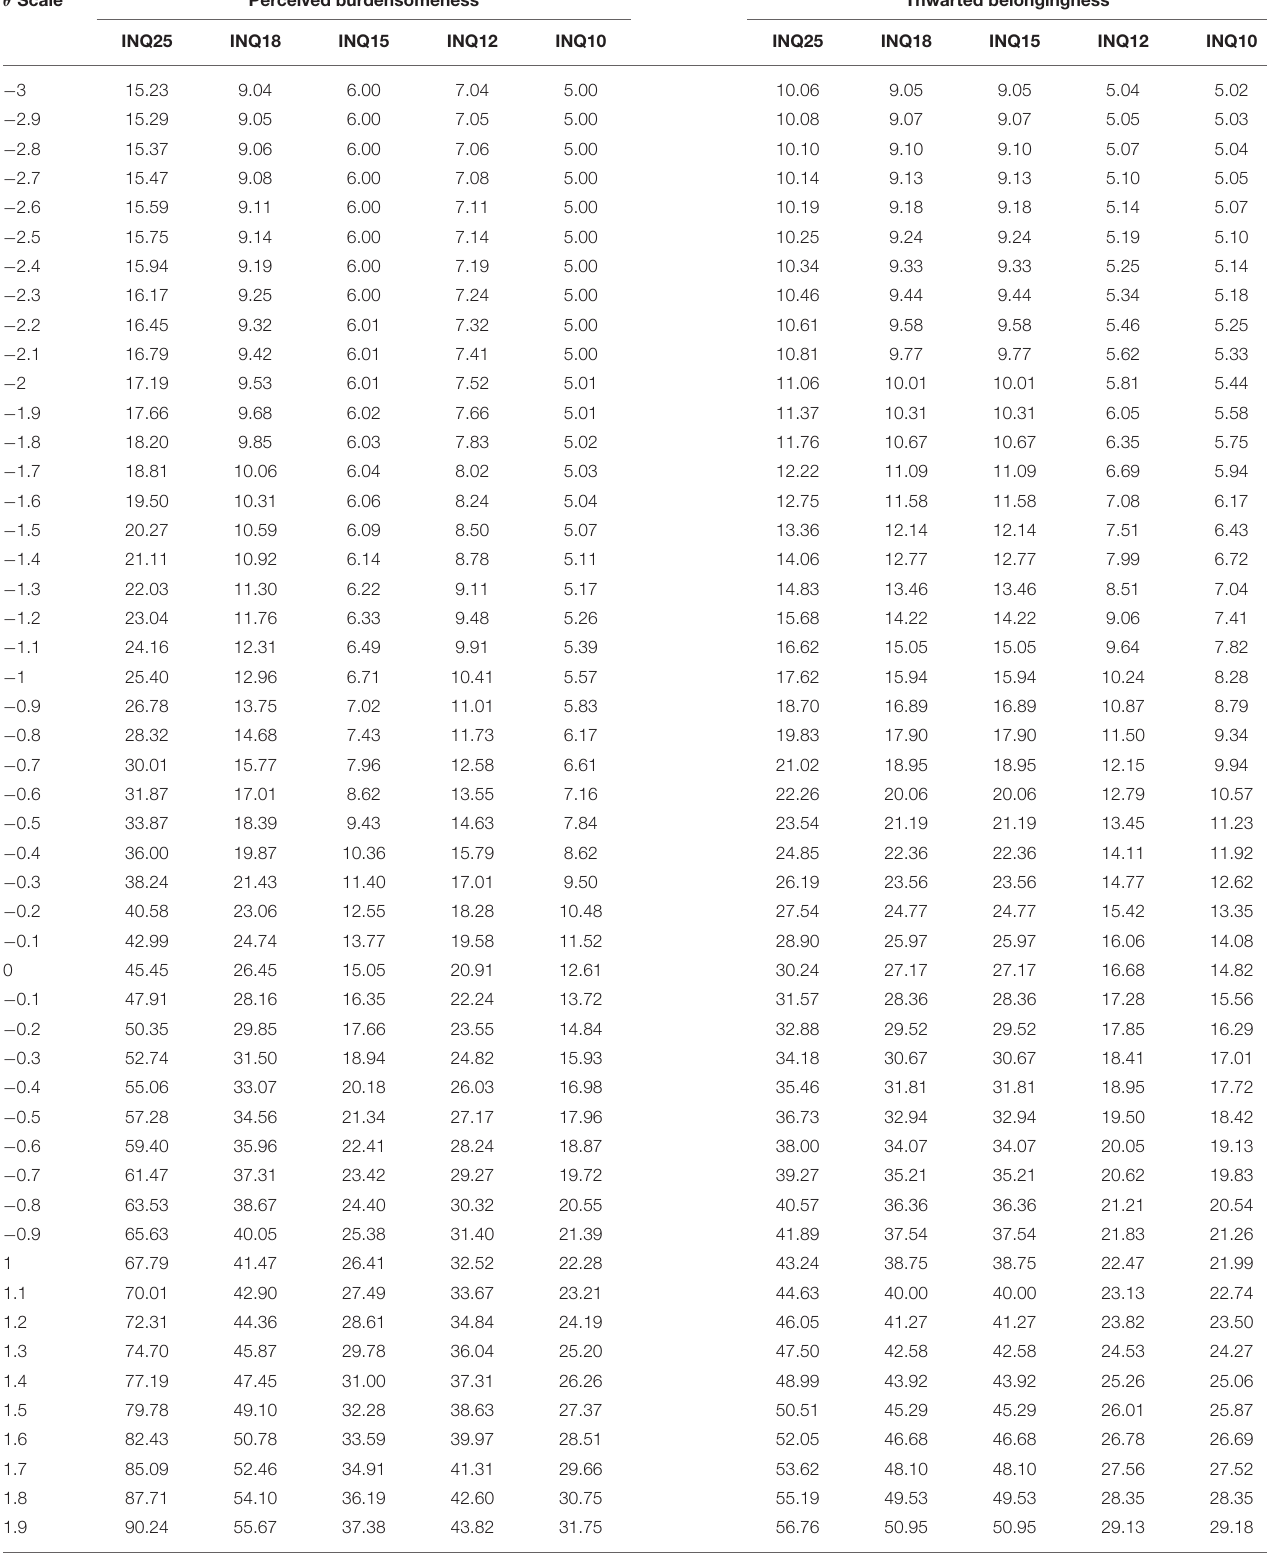
TABLE 6 | Conversion table of five versions of INQ based on expected